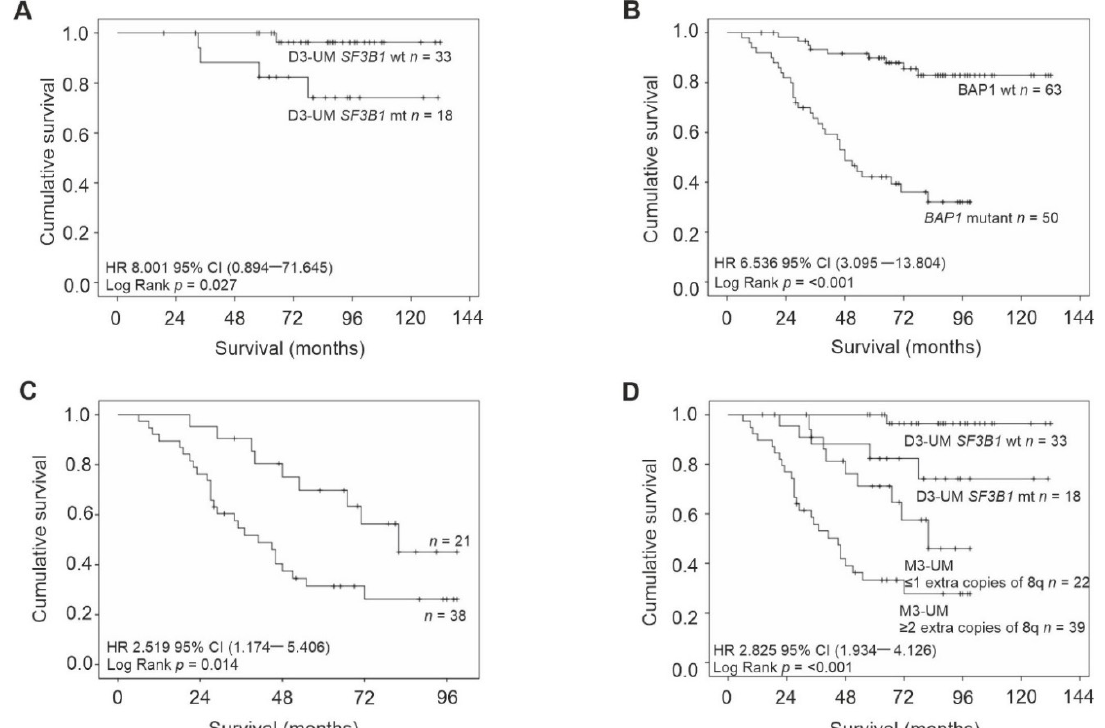
Figure 2. Kaplan–Meier survival curves estimate survival in UM patients stratified by: ( A ) SF3B1 wild-type / mutation status in D3-UM n = 51 (Log Rank, p = 0.027); ( B ) BAP1 wild-type / mutation status n = 113 (Log Rank, p < 0.001); ( C ) extra copies of chr 8q in M3 / ID3-UM n = 59 (Log Rank, p = 0.014) and ( D ) SF3B1 wild-type / mutation status in D3-UM n = 51 and extra copies of chr 8q in M3 / ID3-UM n = 59 (Log Rank, p < 0.001). Number of events indicates the number of deaths due to metastatic melanoma. Log Rank tests were used to compare survival across groups.